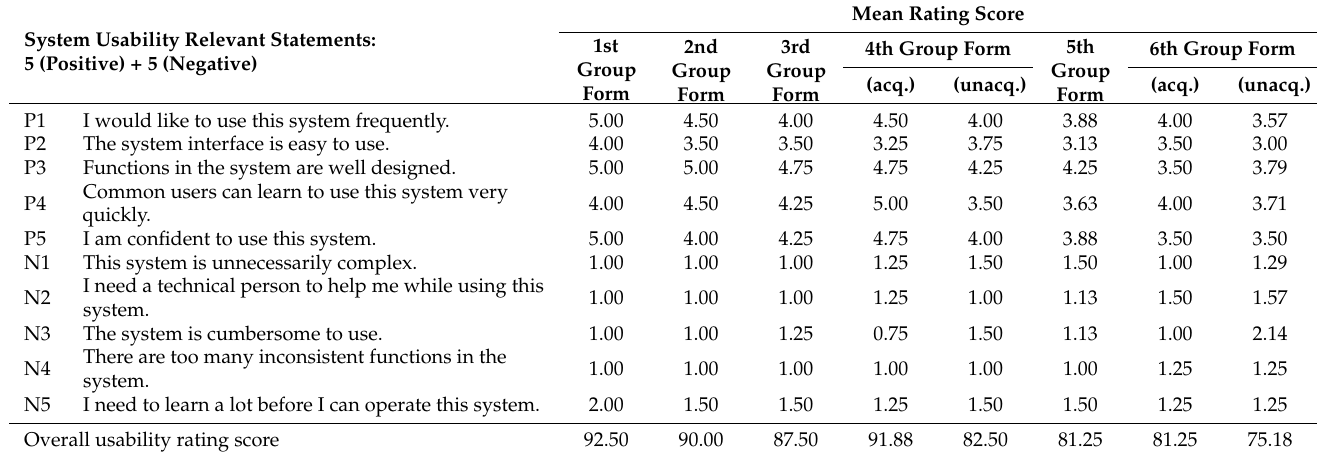
Table 6. SUS evaluation result of the 6 group